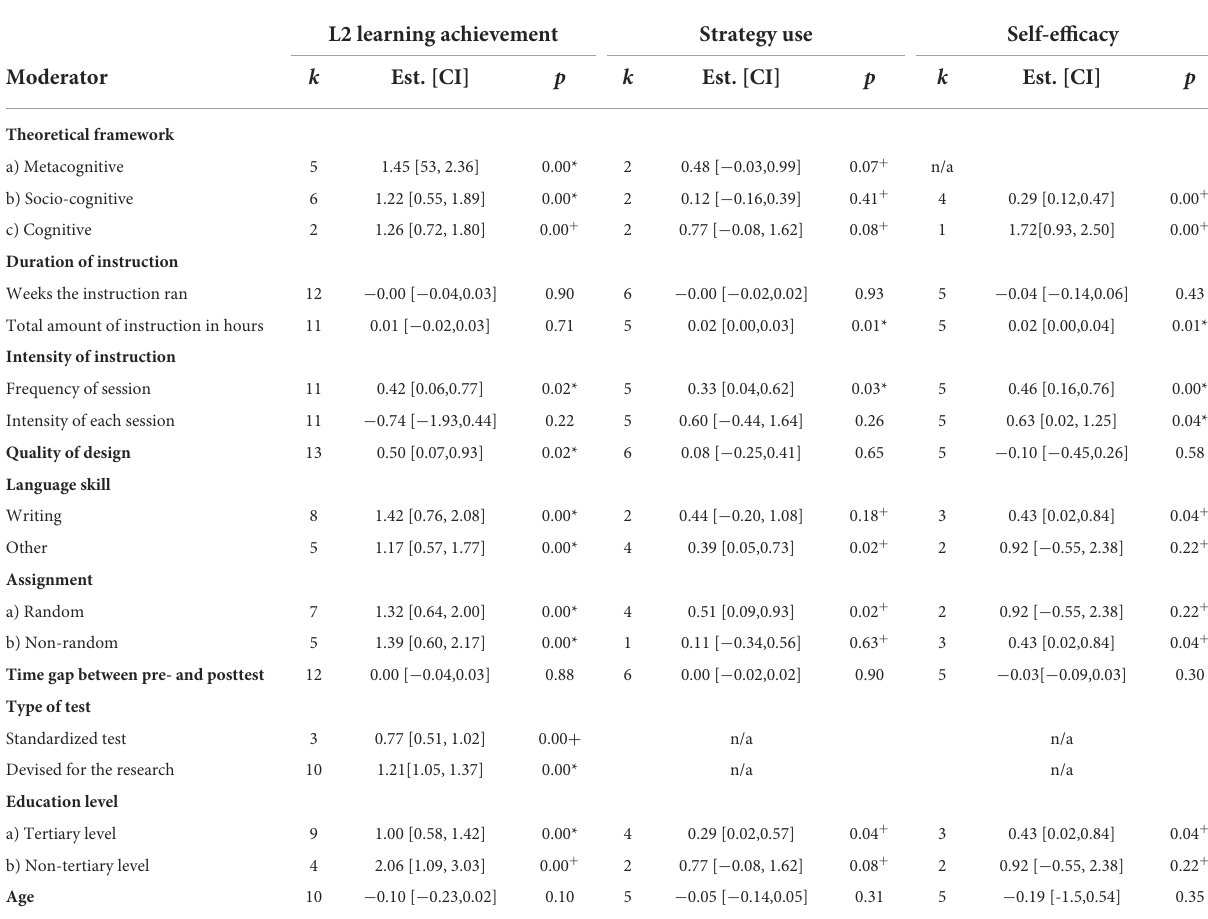
TABLE 3 Results of moderator